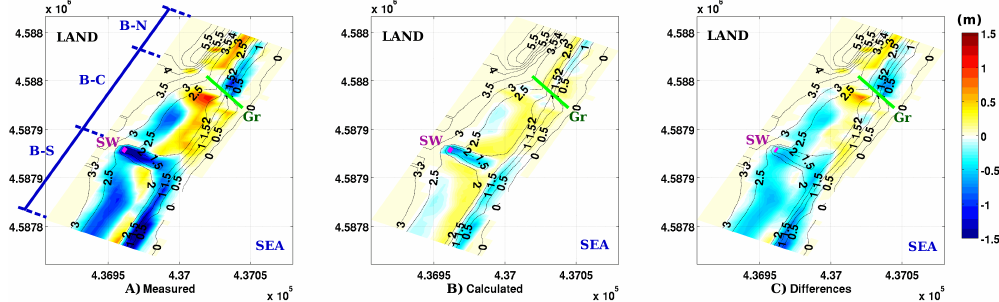
Figure 5. Topography of the emerged beach for the Badalona case. Contour lines represent the initial state of the sedimentary deposit. Colour scale: Blue and red indicate accretion and erosion, respectively. Green (Gr) represents the groyne position. Magenta (SW) represents the sewer outfall position. (a) Differences between the measured morphodynamic states (pre- minus post-storm conditions); (b) differences between the calculated morphodynamic states (pre- minus post-storm conditions); (c) differences between measured and calculated post- storm conditions. All values are in metres.